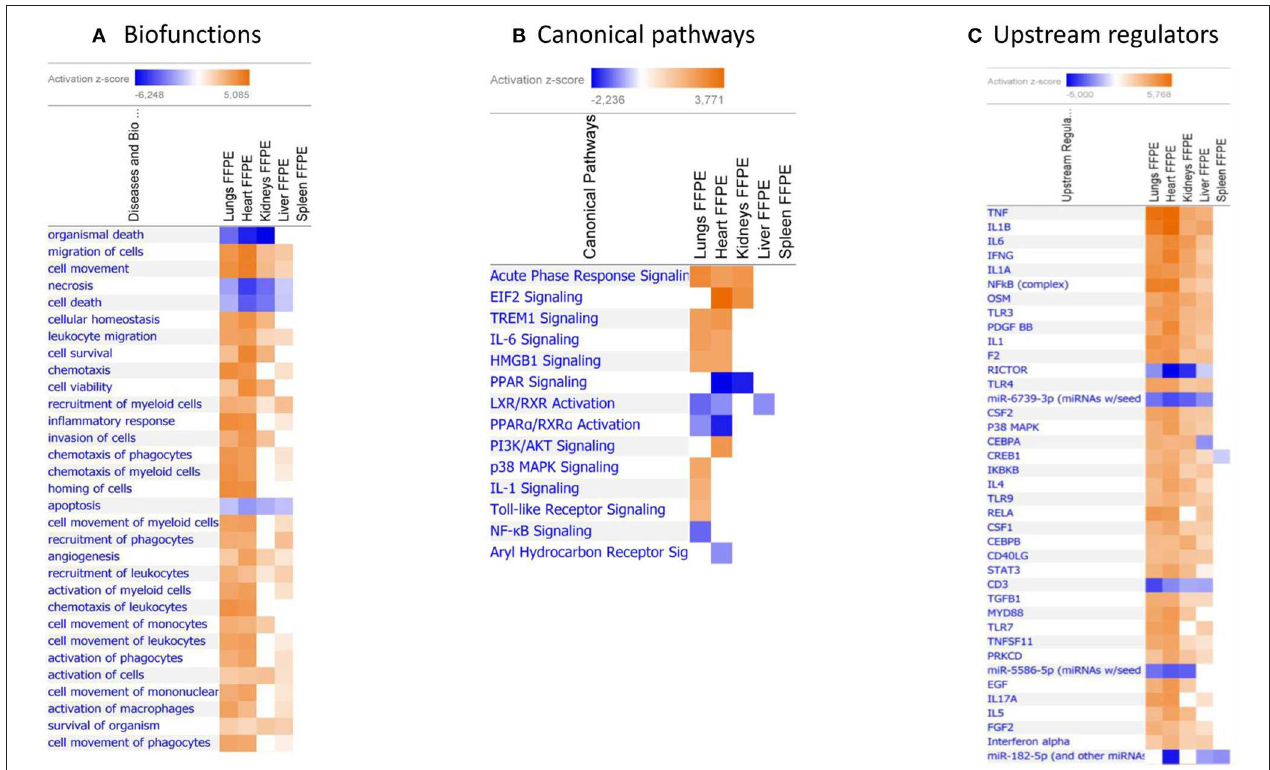
FIGURE 4 | Predicted biofunctions (A) , canonical pathways (B) , and upstream regulators (C) in FFPE tissue samples from patients with meningococcal septic shock. ≪ Comparison analysis ≫ of biofunctions, canonical pathways, and upstream regulators significantly enriched in FFPE tissue samples from lungs, heart, kidneys, liver and spleen from meningococcal septic shock patients vs. controls patients (acute non-infectious death). The figure shows the most up-regulated biofunctions (A) , canonical pathways (B) , and upstream regulators (C) ranked according to expression levels in FFPE tissues from lungs. The Z-score indicates predicted activation state of the biofunctions, canonical pathways, and upstream regulators. Z-score value > | ± 1| are displayed. Blue color or lighter shades of blue indicate a negative Z-score and down-regulation of a biofunction, canonical pathways, and upstream regulators. Orange or lighter shades of orange indicates a positive Z-score and up-regulation of a biofunction, canonical pathways, and upstream regulators. Note that only the top pathways are